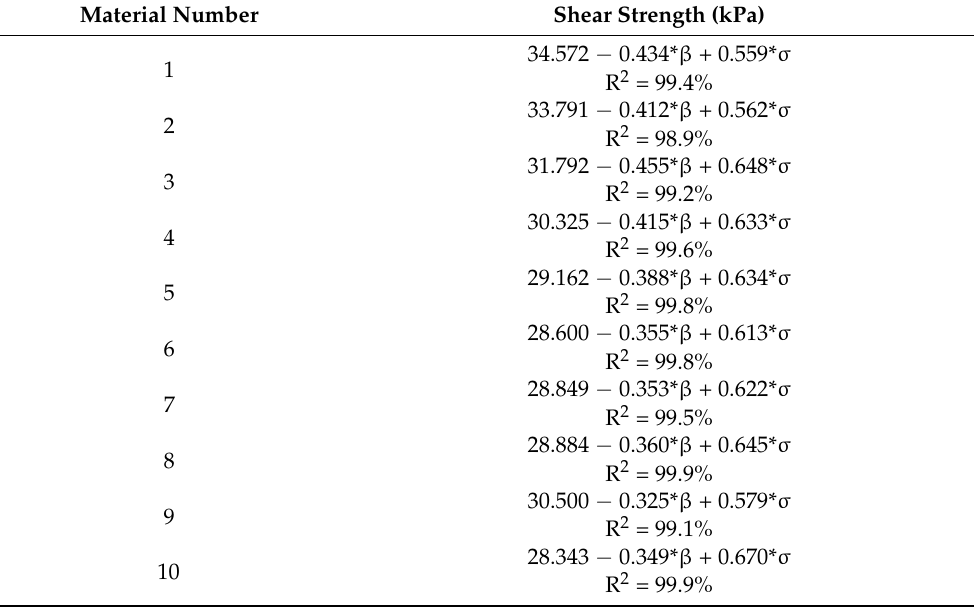
Table 4. Correlations in the case of clay—Saturated seismic